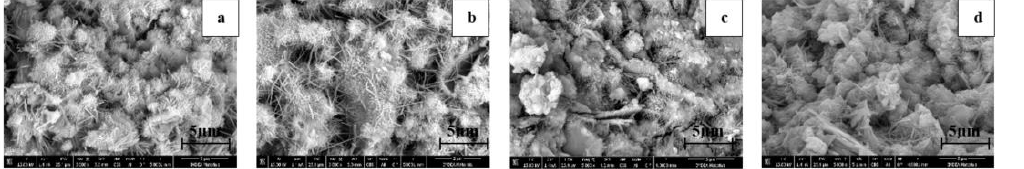
Figure 4. SEM micrographs 28 days after the preparation of ( a ) control sample, ( b ) 0.02 wt.% MWCNTs reinforced sample, ( c ) 0.1 wt.% MWCNTs reinforced sample and ( d ) 0.02 wt.% SWCNTs reinforced sample.